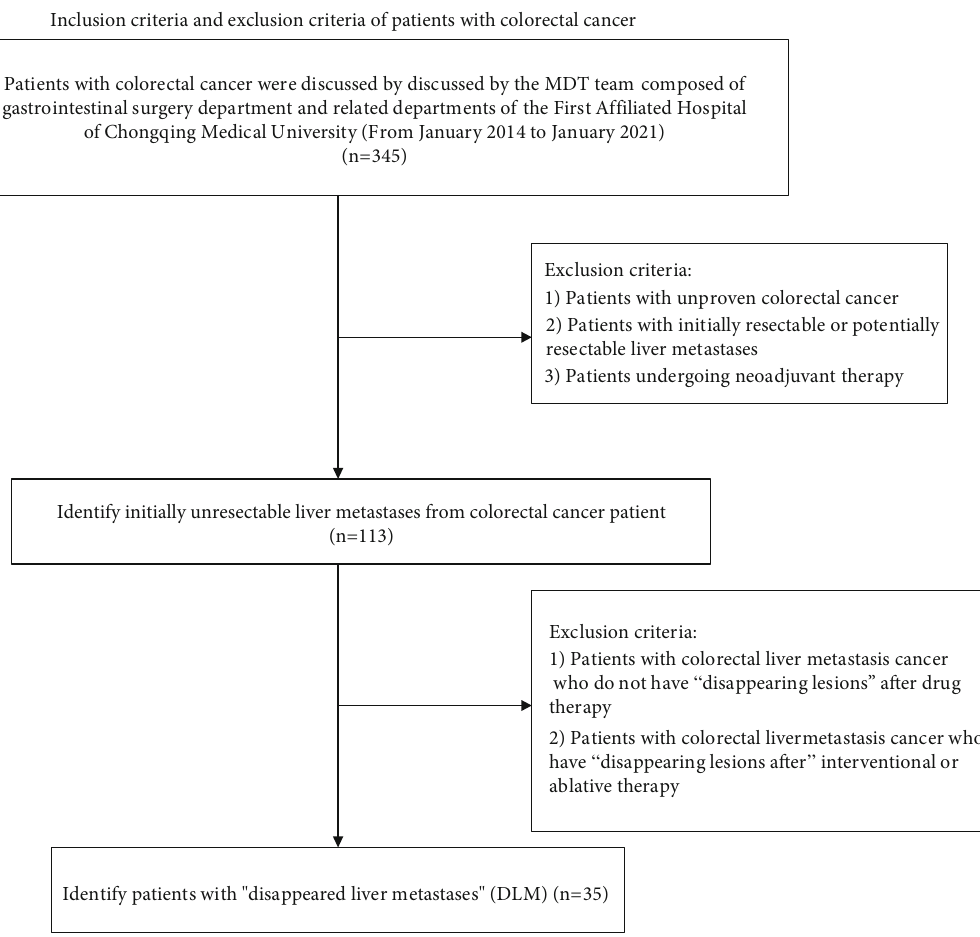
Figure 1: Inclusion criteria and exclusion criteria of patients with colorectal cancer. Abbreviations: DLM: disappearing liver